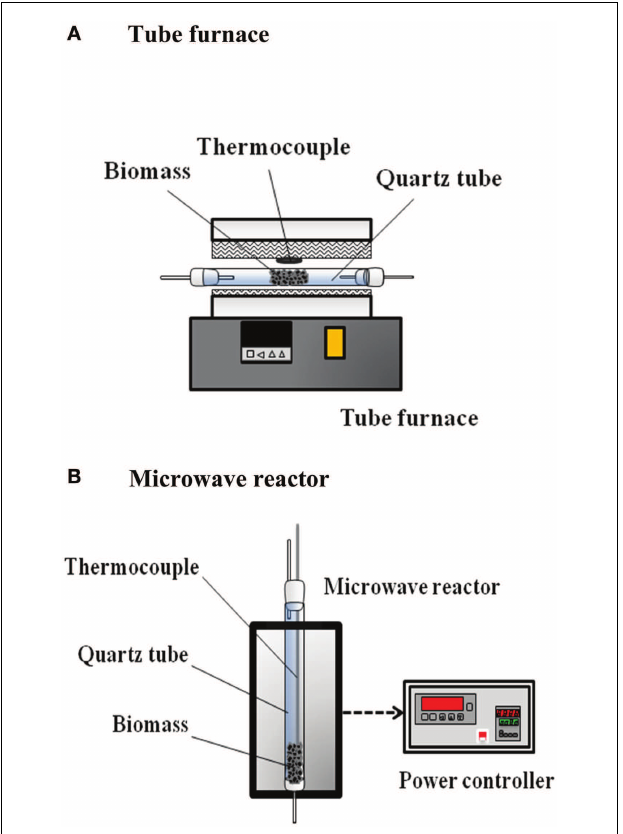
FIGURE 1 | Schematics of pyrolysis reactors with (A) conventional heating and (B) microwave-assisted heating